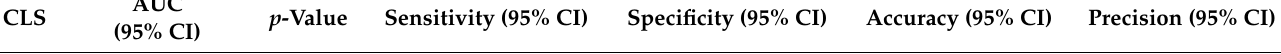
Table 3. Prediction Ability of the Reference Model (LR2, Linear Regression2) and five Machine Learning Models, measured in terms of AUC-ROC, Sensitivity, Specificity, Accuracy and Precision values to predict MACE, using 8-fold cross-validation of 123 patients from the testing